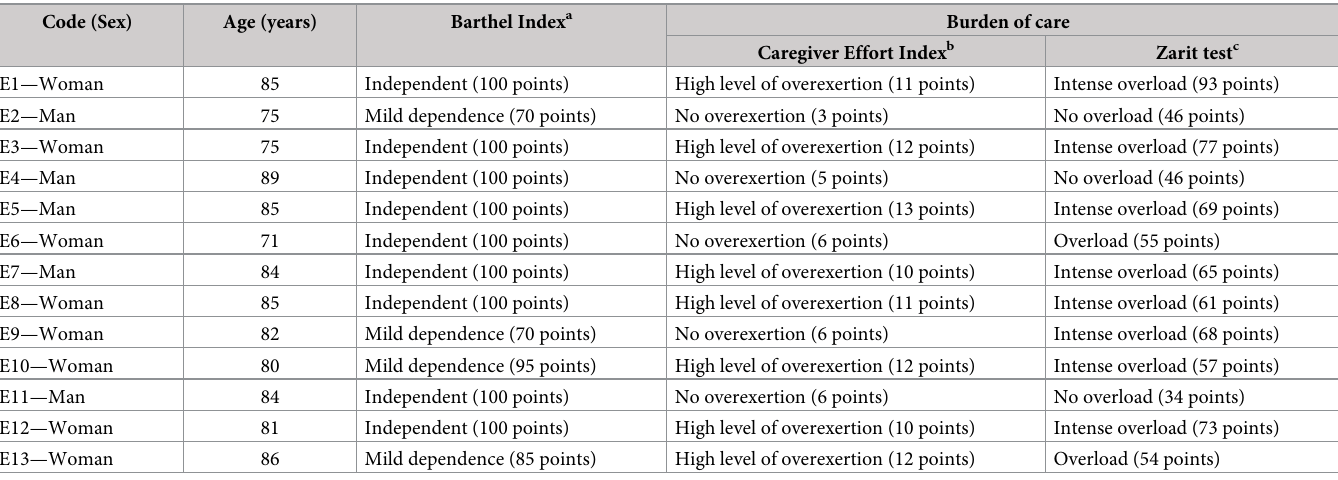
Table 1. Characteristics of older